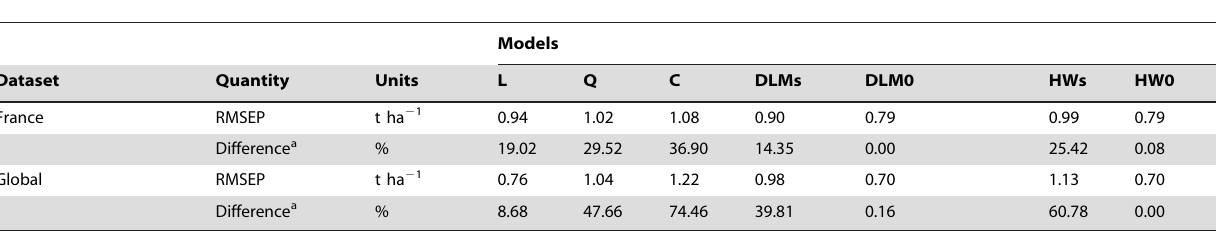
Table 3. Root mean square error of ten-year ahead predictions (RMSEP) obtained with two different datasets for several statistical models: linear regression (L), quadratic regression (Q), cubic regression (C), dynamic linear models with and without trend (DLMs, DLM0), and Holt-Winters with and without trend (HWs, HW0).